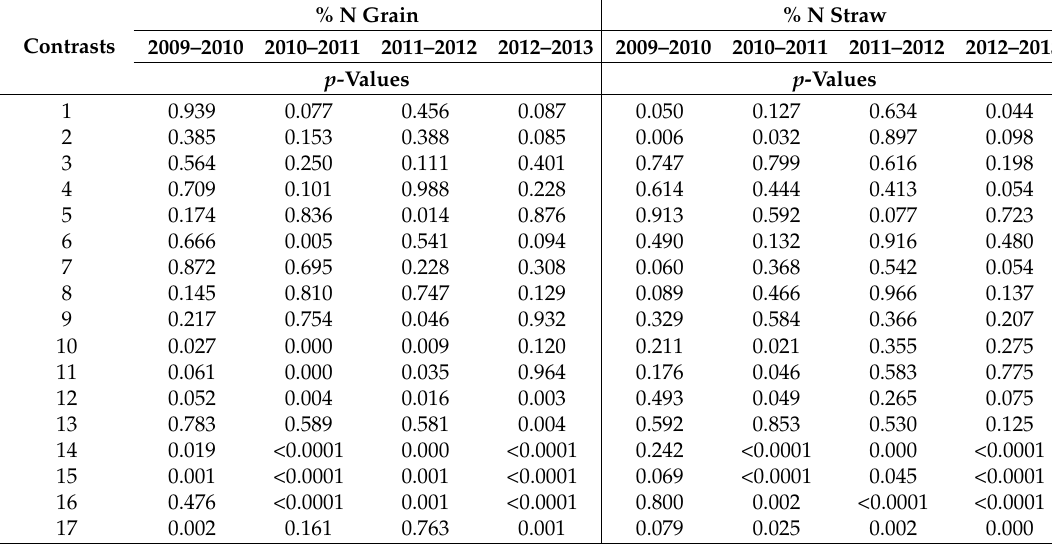
Table 5. P values of contrasts to compare the effects on wheat nitrogen concentration in grain and in straw in four cycles (2009–2010 to 2012–2013), as influenced by selected treatments composed of urea sources, timing, and methods of fertilizer application at the International Maize and Wheat Improvement Center (CIMMYT), in the Yaqui valley, near Ciudad Obregon, Sonora, Mexico. % N Grain % N